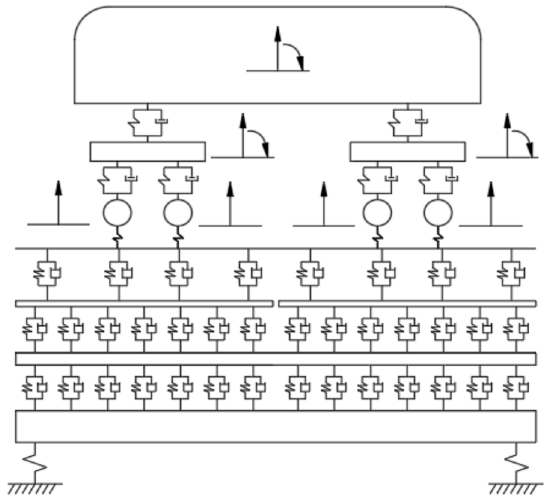
Figure 17. Multiple-layer model for the vehicle-rail-viaduct system.